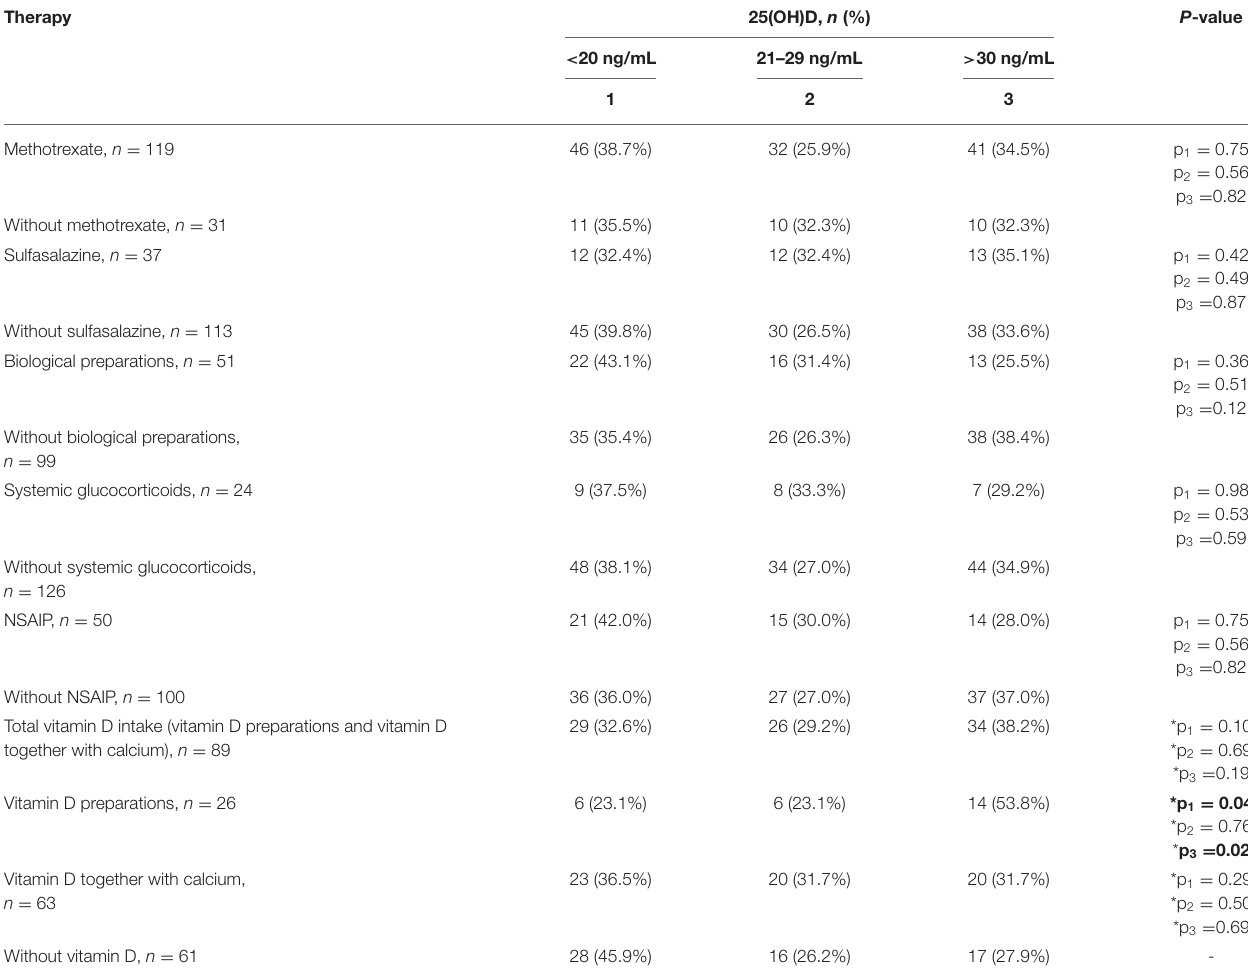
TABLE 7 | Distribution of vitamin D status among patients in the JIA group as a function of the therapy used.